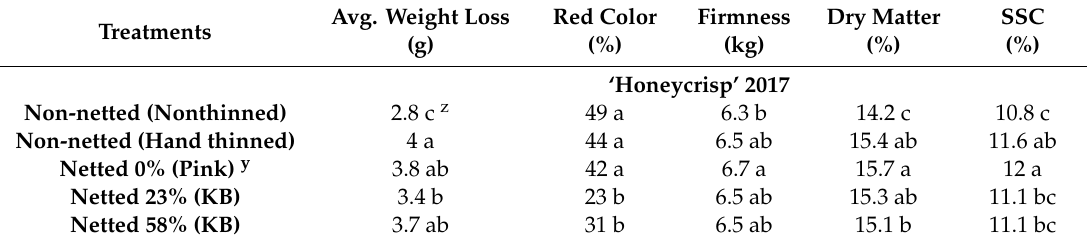
Table 5. E ff ect of netting treatments in 2017 and 2018 on ‘Honeycrisp’ postharvest quality (6 months storage) as determined by average weight loss of fruit, red color (percentage red), flesh firmness, dry matter, and soluble solids concentration